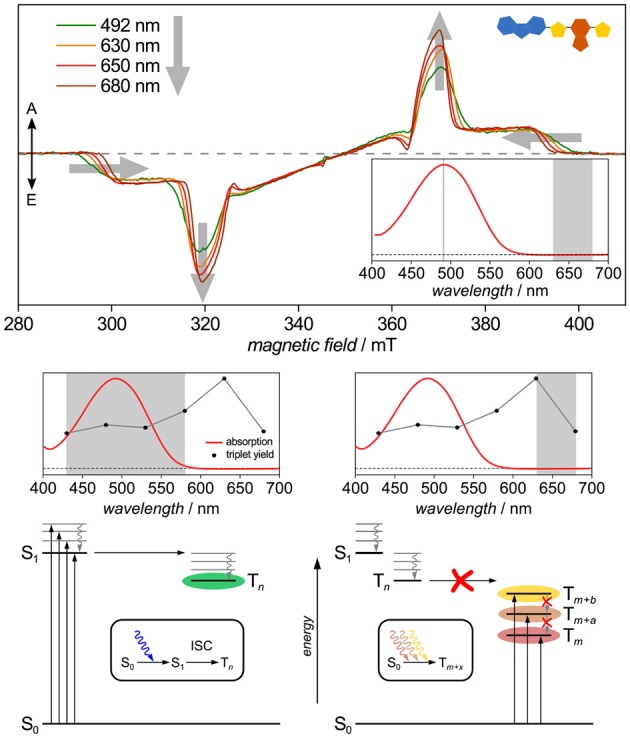
Triplet routes: Evidence for spin-forbidden direct S0 → T excitation. Exciting CbzTBT, the repeat unit of PCDTBT, up to 80 nm red-shifted from the onset of its absorption band leads to distinct triplet states that slightly differ in both, shape and intensity from those observed upon excitation within the absorption band and attributed to originating from intersystem crossing from the excited singlet state. Ruling out aggregation and different conformations, this is attributed to a spin-forbidden direct S0 → T excitation. All TREPR spectra have been recorded at 80 K and X-band frequencies (about 9.7 GHz). For details see Meyer et al. (2017).